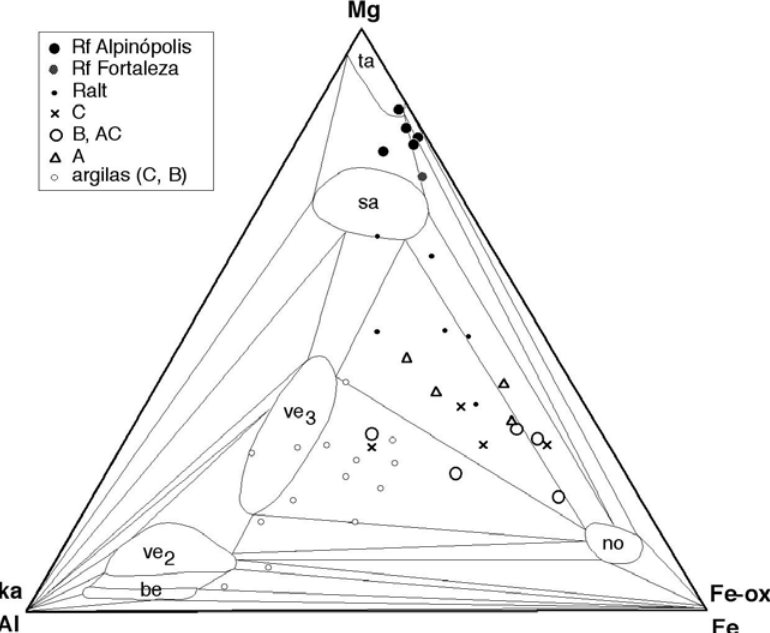
Figura 7. Avaliação da possibilidade de ocorrência das fases minerais a partir da composição química da fase sólida, aplicando-se o diagrama de fases de Righi & Meunier (1995) para o sistema Fe-Al-Mg. Símbolos como na figura 2; ka: caulinita e Fe-ox: óxidos de ferro; ta: talco; sa: saponita; ve3: vermiculita trioctaédrica; ve2: vermiculita dioctaédrica; be: beidellita; no: